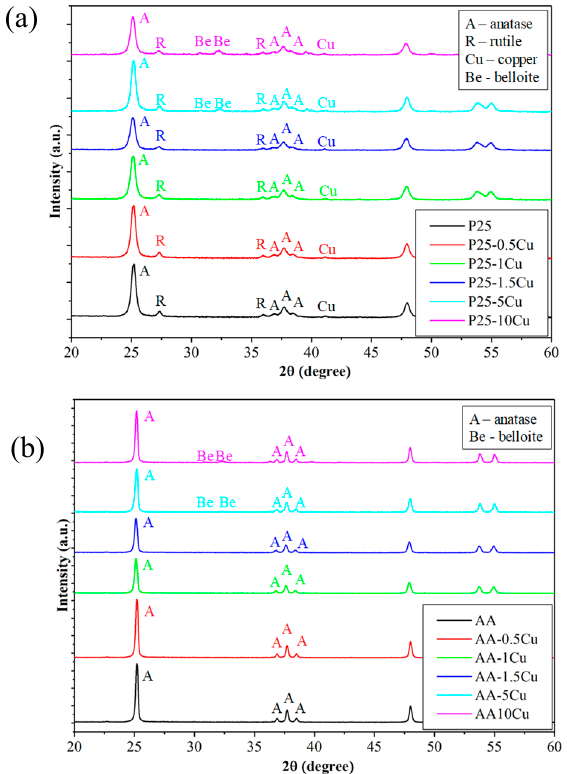
Figure 2. X-ray diffraction (XRD) patterns of the composites. ( a ) Evonik Aeroxide P25 (89% anatase and 11% rutile photocatalyst (P25). ( b ) Aldrich anatase (AA)-based. New reflections were detectable between 30–35 (2 θ °) when 10% copper is present, pointing out the presence of belloite.